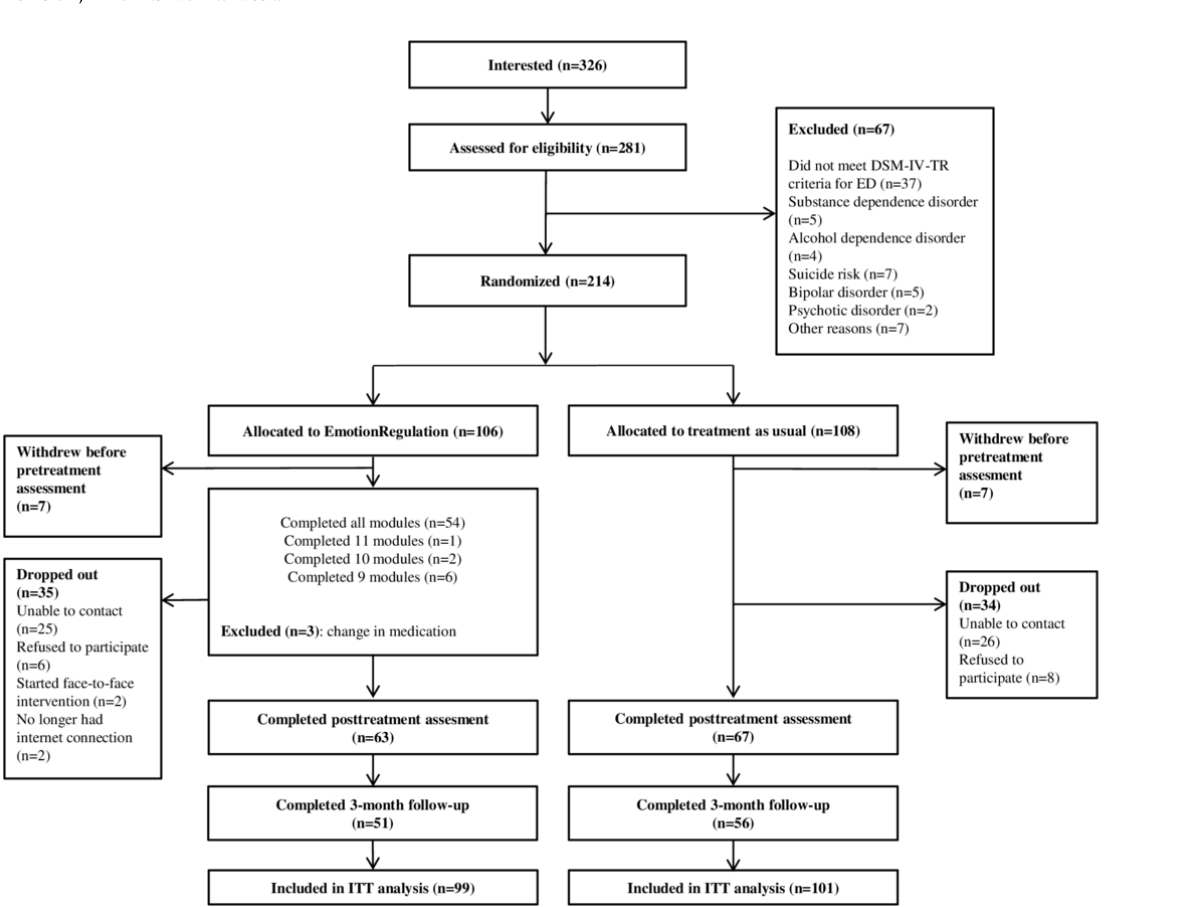
Figure 1. Flowchart of participants. ED: emotional disorder; DSM-IV-TR; Diagnostic and Statistical Manual of Mental Disorders, Fourth Edition, Text Revision; ITT: